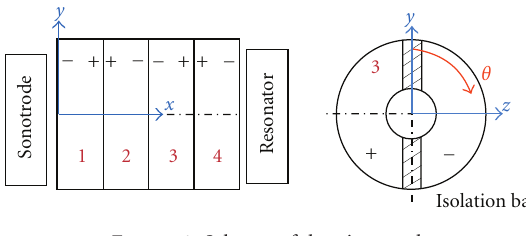
Figure 9: Scheme of the piezostack.